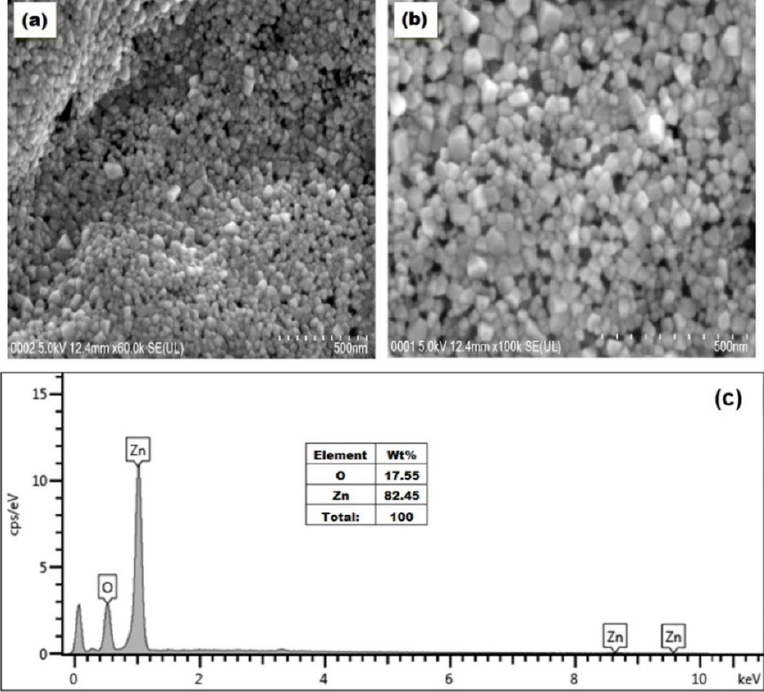
Figure 3. Scanning electron microscopic images of zinc oxide nanostructures at different magnifica- tions ( a , b ). EDX pattern of zinc oxide nanostructures ( c ).